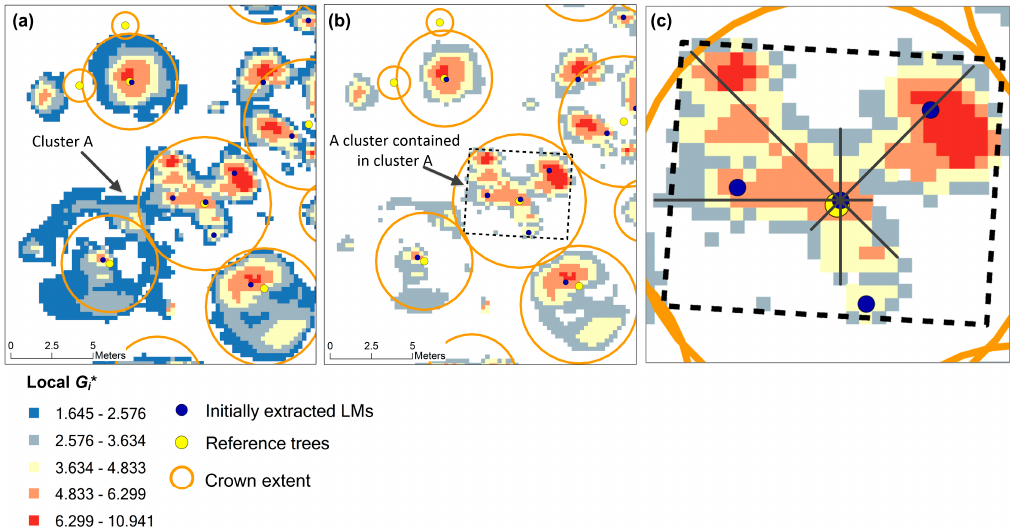
Figure 6. ( a ) Extraction of cells under a significance level of 0.10; ( b ) Removal of all cells with local G i * values smaller than 2.576 (critical value under significance level of 0.01); ( c ) Enlargement of the cluster highlighted by a black rectangle in ( b ) and calculation of new LM filter window size along four directions. The CHM resolution is 0.25 m, the LM filter size is 7 × 7, and the maximum distance threshold is 1.5 m.